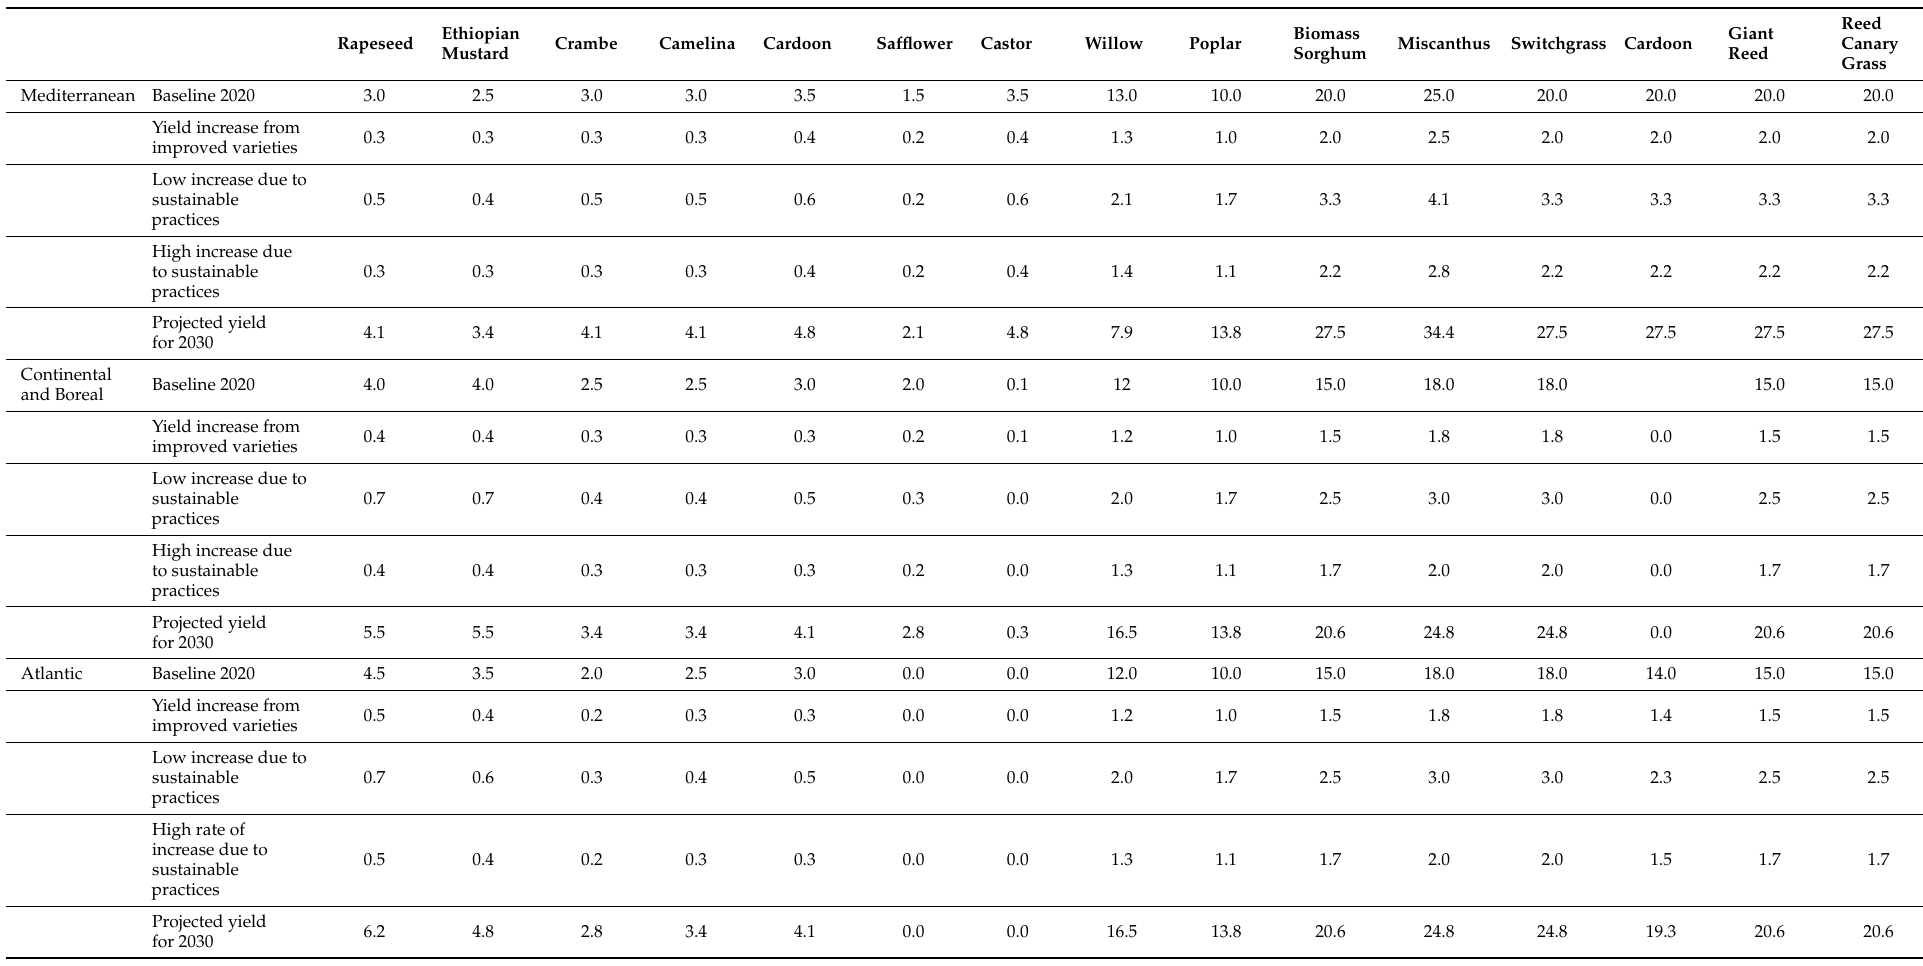
Table A1. Observed attainable yields and potential yield increases of the understudy crops in conventional farming land